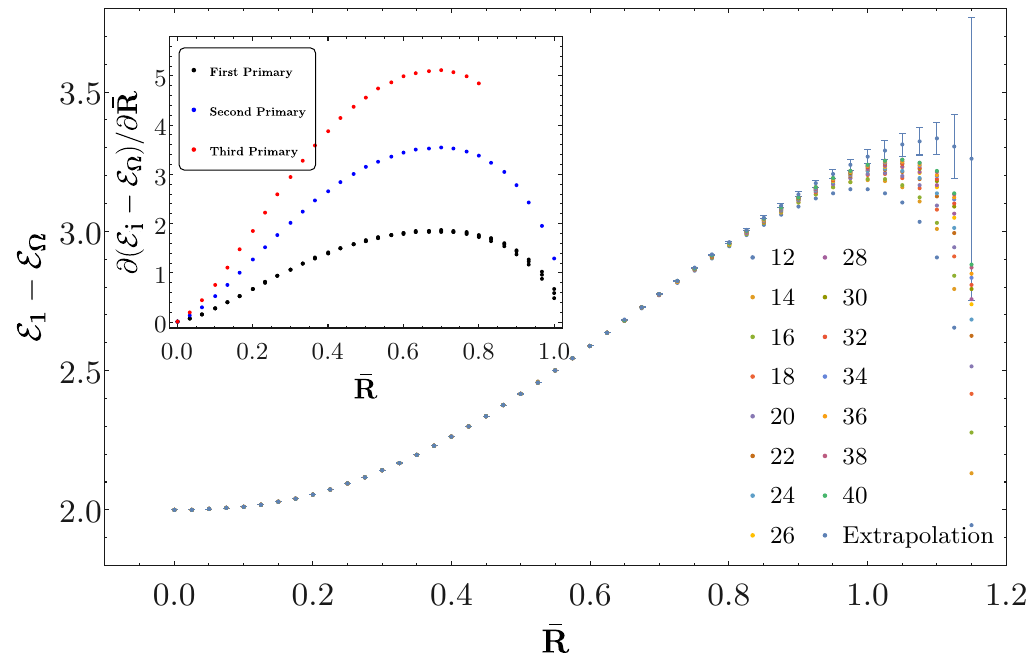
Figure 19. Main plot: energy of the first excited state in the Lee Yang model, as a function of the radius of AdS, for various choices of cutoff. The error bars are computed according to the procedure explained in subsection 4.1.2. In the inset, the derivative of the gap is computed discretely, by measuring the gap at two nearby values of ¯ R